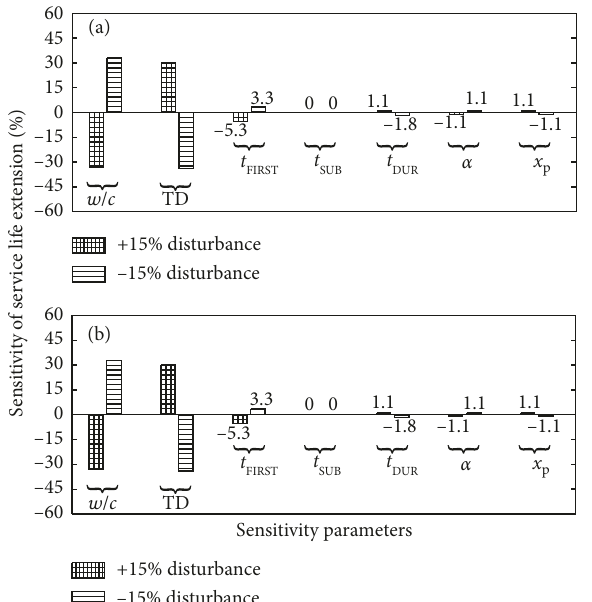
Figure 9: Sensitivity of the service life of concrete structures with SL1 and SL2.